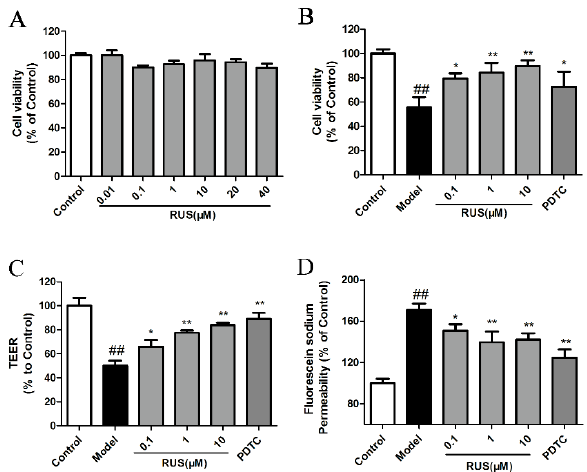
(white arrow) formation (Figure 6C).